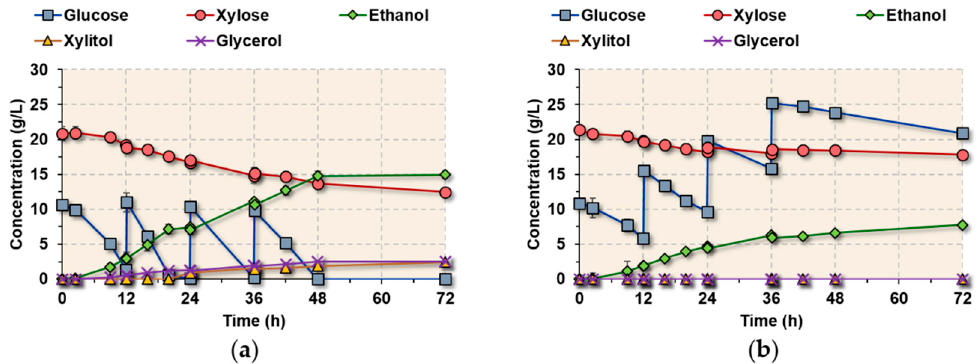
Figure 5. Time course of batch fermentation of synthetic medium in the SHF + fed-batch SSF mode. Assays were performed with ( a ) C. intermedia CBS 141442 and ( b ) S. stipitis CBS 6054 as fermentative microorganisms. Of the synthetic medium 20 mL containing 200 g / L glucose and 20 g / L xylose was added 12 h, 24 h and 36 h after inoculation. Values were calculated from two independent cultivations and the error bars indicate the minimum and maximum values.